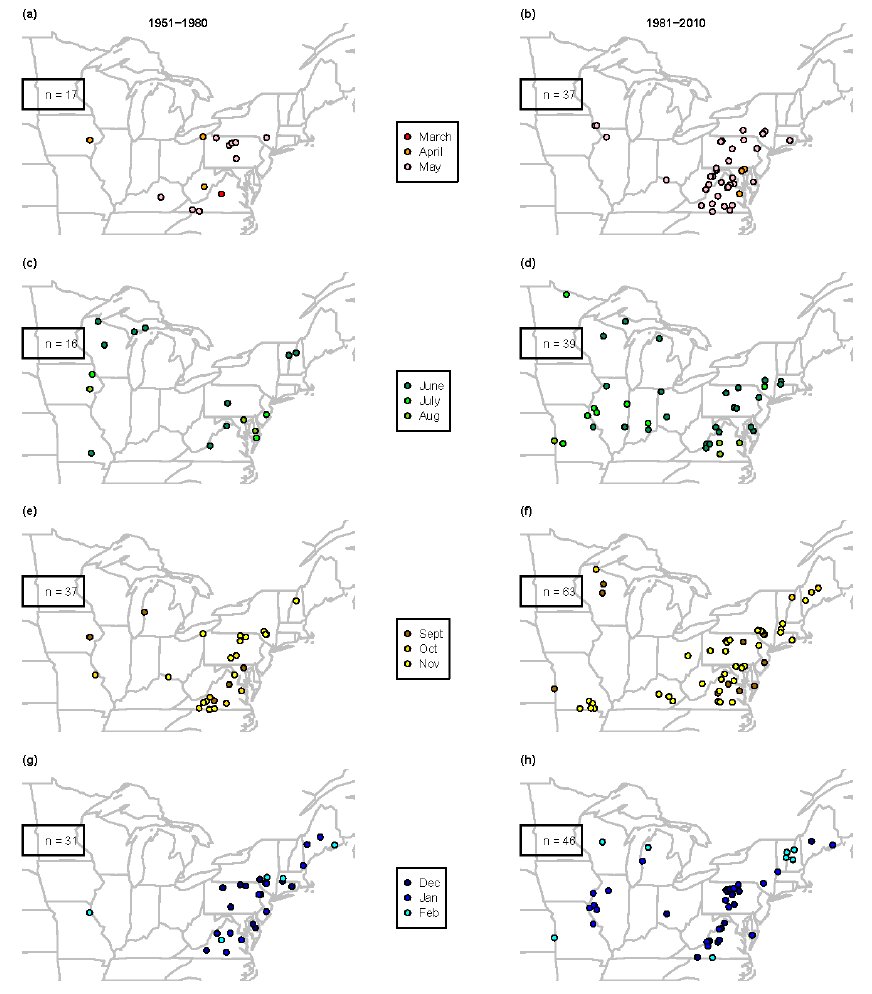
Figure 6. Spatial patterns of stations with unique seasonal modes (no overlapping density